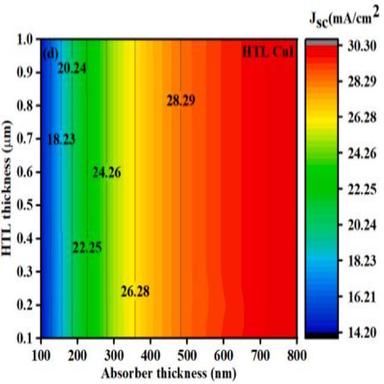
Contour mapping of Jsc for FASnI3 absorber and HTLs thickness (a) CBTS (b) CFTS (c) Cu2O (d) CuI (e) CuO (f) CuSbS2 (g) CuSCN.